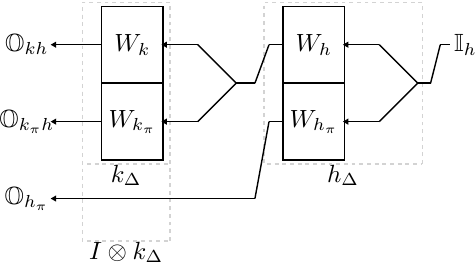
Figure 4: The composition of two vulnerability profiles as a map in the probability